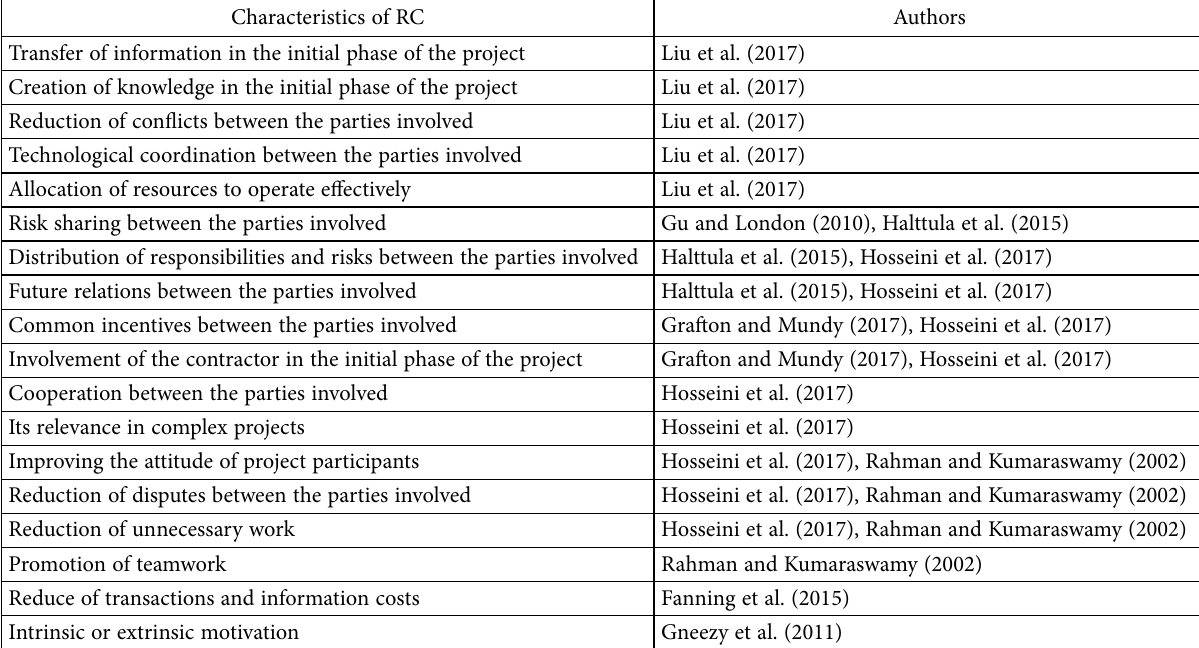
Table 1. Main characteristics of RC that contribute to reducing